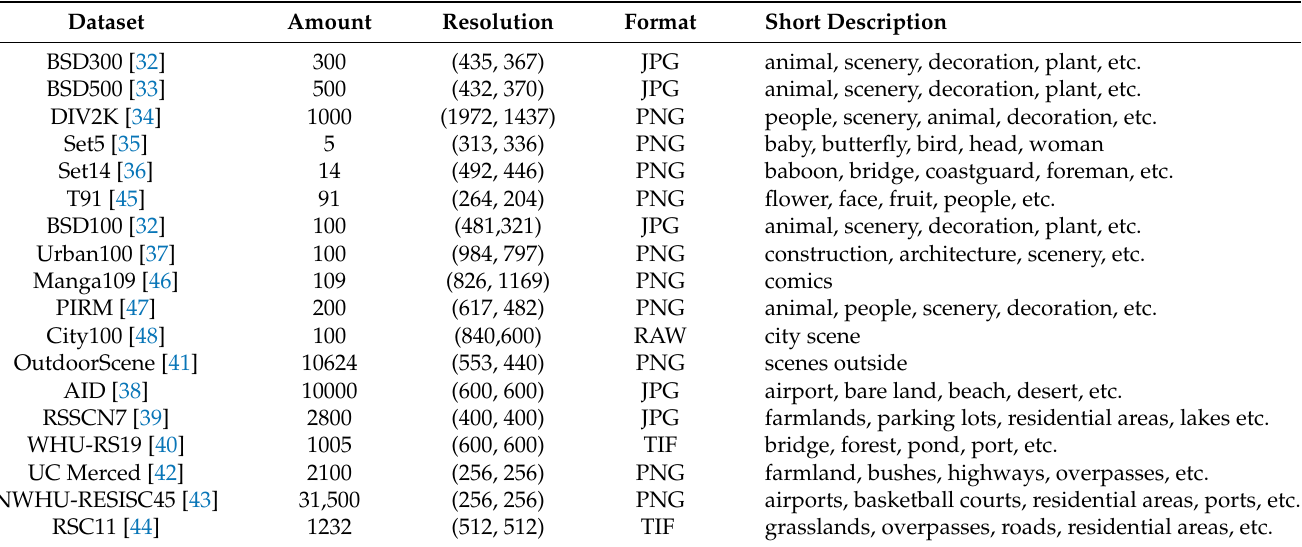
Table 1. Common datasets for image super-resolution (SR) and some remote sensing image